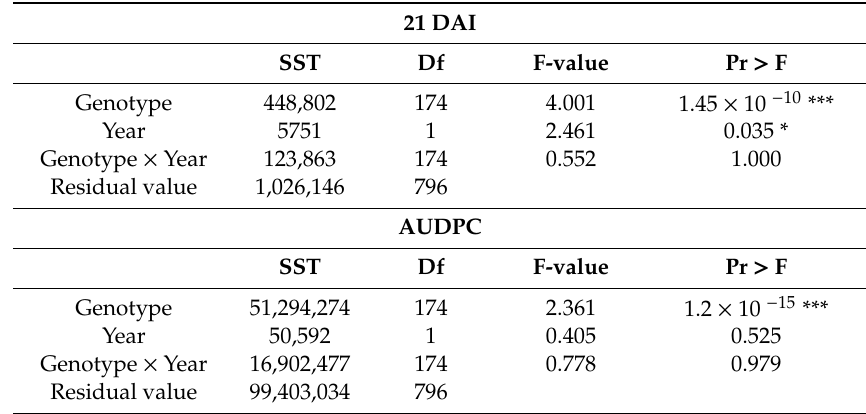
Table 2. Result of the analysis of variance based on the infection values 21 DAI and the AUDPC data (21 DAI: infection severity % on the 21st day after inoculation; AUDPC: area under the disease progress curve), under greenhouse conditions in 2007 and 2009 ( n = 173 + 2